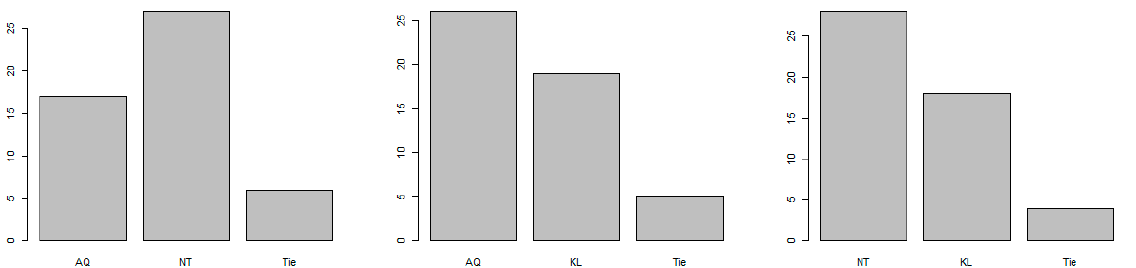
Figure 3. The distribution of discrete preferences along with counts of indecisiveness for drinking water brands’ data.